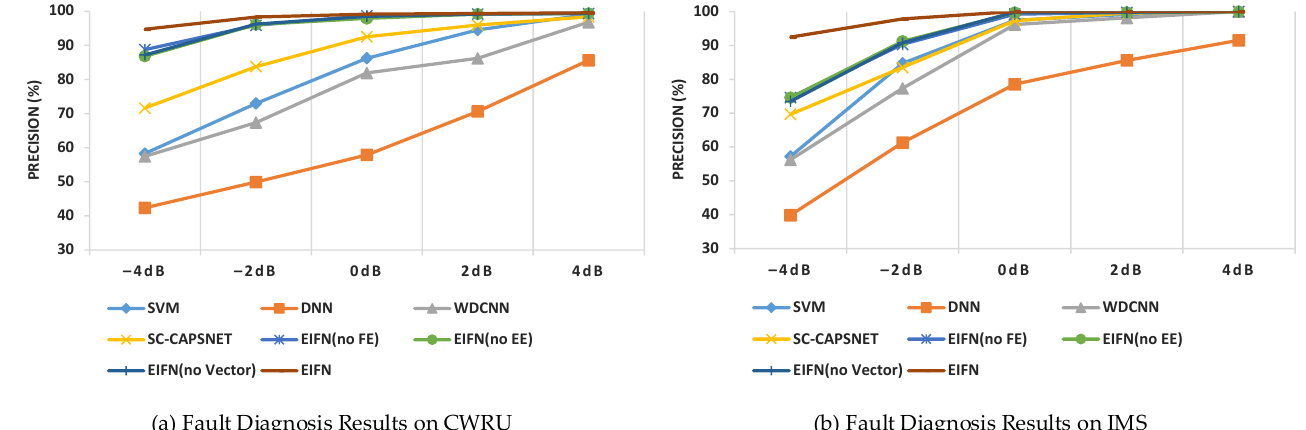
Figure 14. The comparison of diagnostic precision in different SNR noise environment. The abscissa is the SNR, and the ordinate is the fault diagnosis precision.